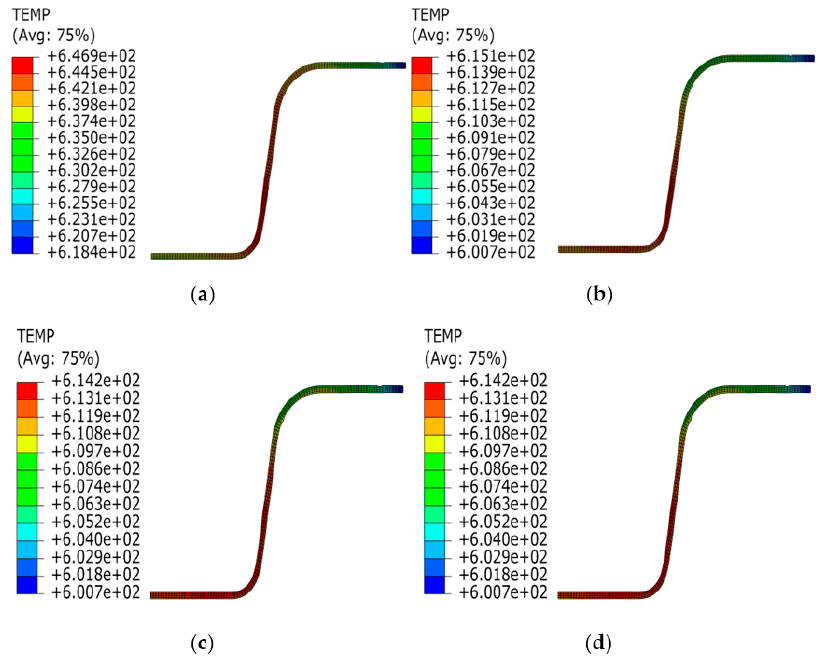
Figure 3. Predicted temperature distribution with a different holding time of ( a ) 5 s, ( b ) 8 s, ( c ) 10 s, and ( d ) 12 s.